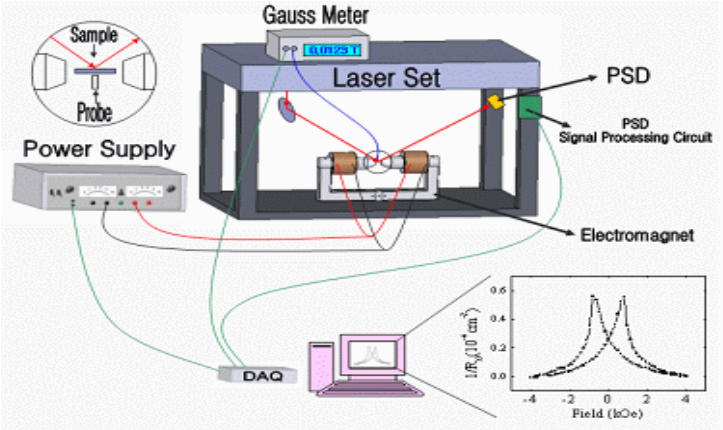
Figure 8. Measurement set up for magnetostriction.